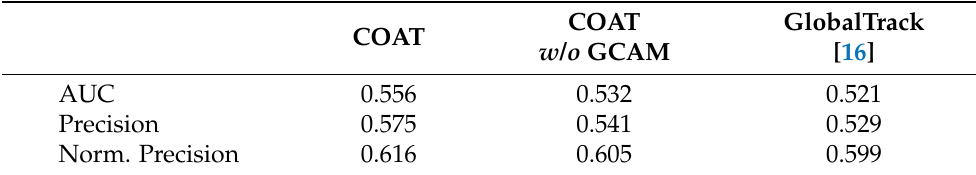
Table 3. Ablation analysis on the global context attention module. Results without the global context attention module are shown in the second